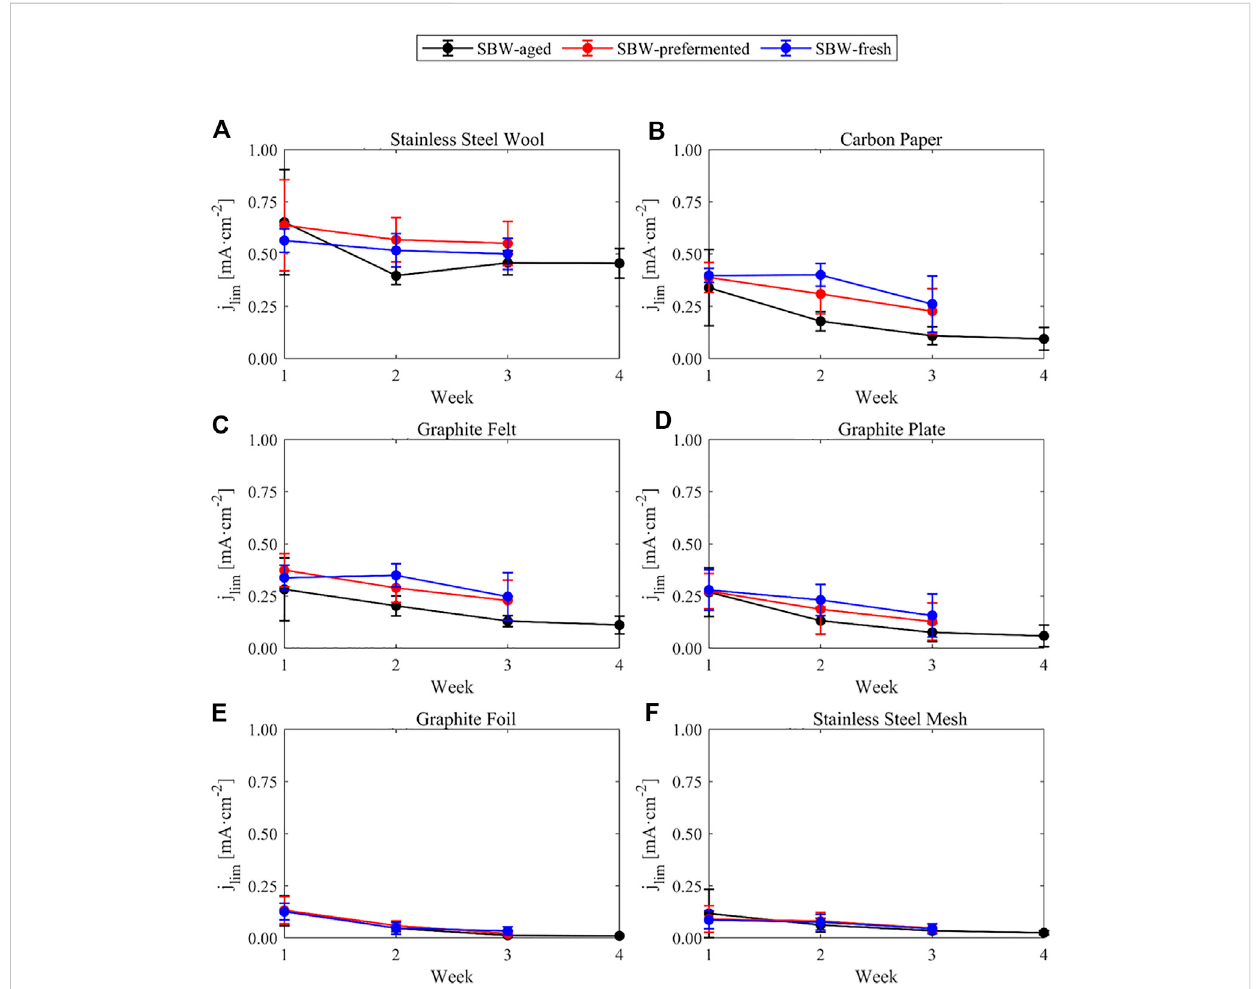
Limitingcurrentdensity( j lim )ofthebioanodesthroughouttheweeksoftheexperimentandboundwithlinesforvisualaid.Dataseriesweretestedin SBW media with different degrees of fermentation. (A) Stainless-steel wool (B) Carbon paper (C) Graphite felt (D) Graphite plate (E) Graphite foil (F) Stainless-steel